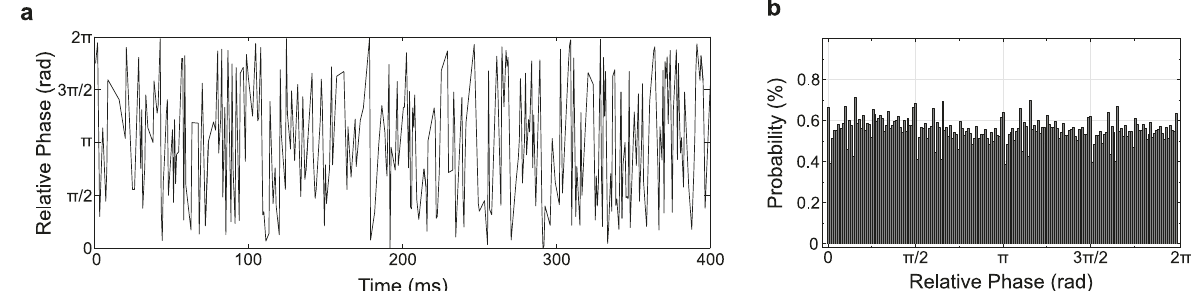
Fig. 3 Relative phase between clockwise and counterclockwise trains. a Relative phase drift between clockwise and counterclockwise trains of Alice V and Bob H 33 . The relative phase between clockwise and counterclockwise trains of the Alice V – Bob H 33 connection is arbitrarily changed with 1.43 rad per train. Since the optical pulse train had a period time of ~8 ms, it was indicated in units of rad per train rather than rad per millisecond. b Probability distribution of the relative phase between the clockwise and counterclockwise trains of Alice V and Bob H 33 . The randomly distributed probabilities indicate that the phase stability from the common path nature is not suf fi cient in our experimental setup. The bin width of the relative phase is